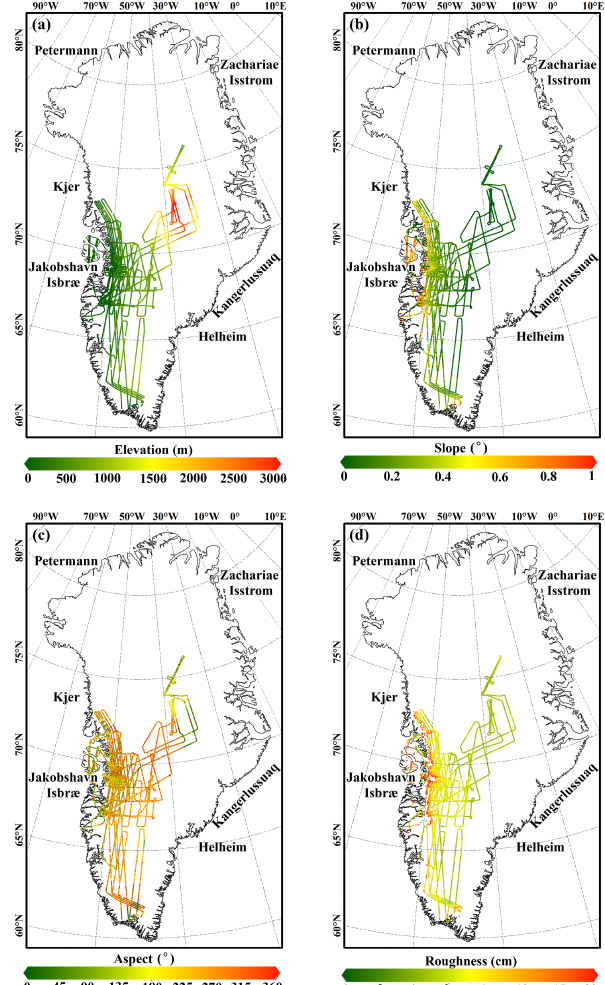
Figure 1. IceBridge data acquired in May 2019 which were used to evaluate the generated ICESat-2 DEM, covering regions in Green- land with various terrain conditions: (a) elevation, (b) slope, (c) as- pect, and (d) roughness. Labels in the picture are the main glaciers in